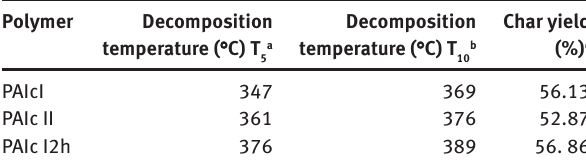
Table 3: Thermal behavior of PAIs. Polymer